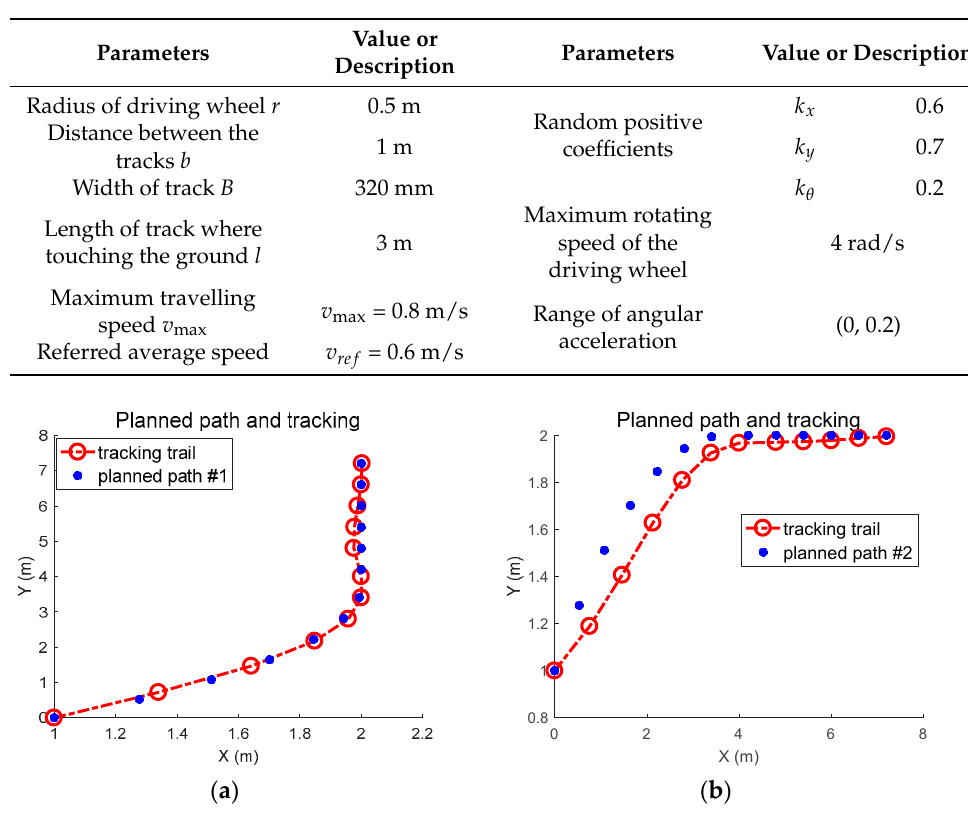
( b ) Figure 5. Path tracking results using different sets of values. ( a ) The differences between the planned positions along path #1 and the real positions during tracking; ( b ) The differences between the planned positions along path #2 and the real positions during tracking. Incidentally, some other sets of